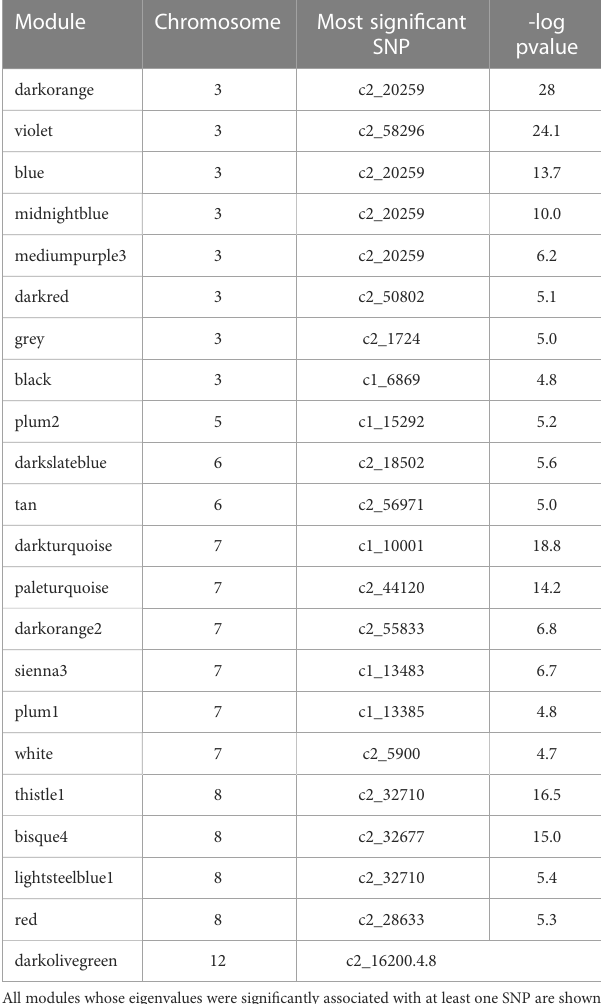
TABLE 2 Modules signi fi cantly associated with SNPs by